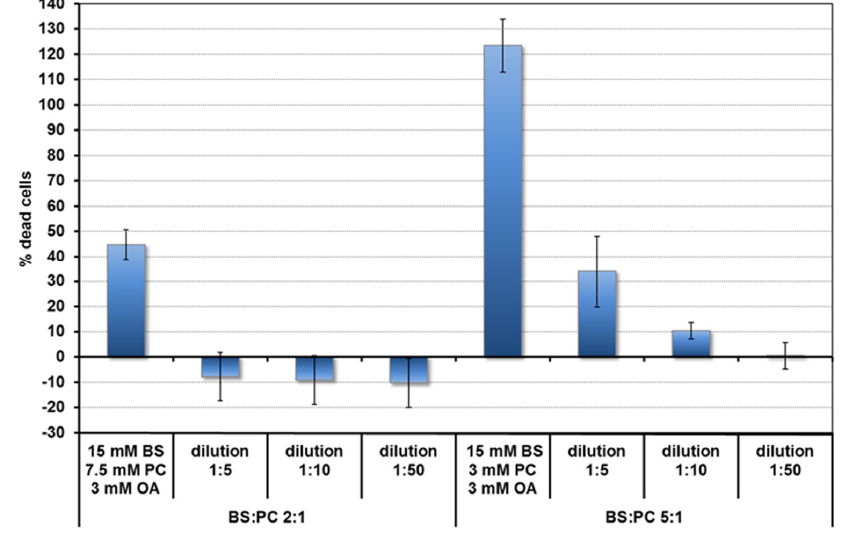
Figure 1. Toxicity of mixed micelles (fed state) to Caco ‐ 2/TC7 cells depending on BS:PC ratio and concentration.